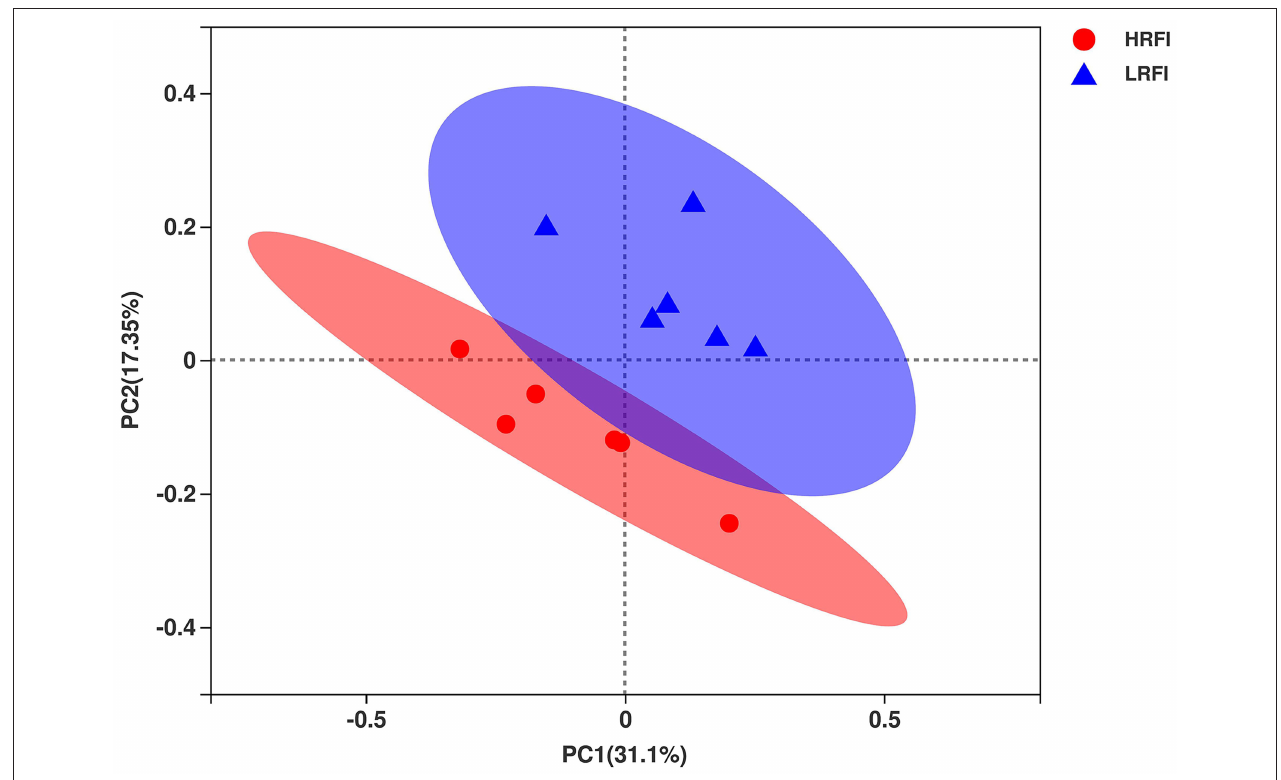
FIGURE 1 | The principal coordinate analysis (PCoA) of the ruminal bacterial communities. Individual points represent a ruminal sample and colors represent RFI groups.